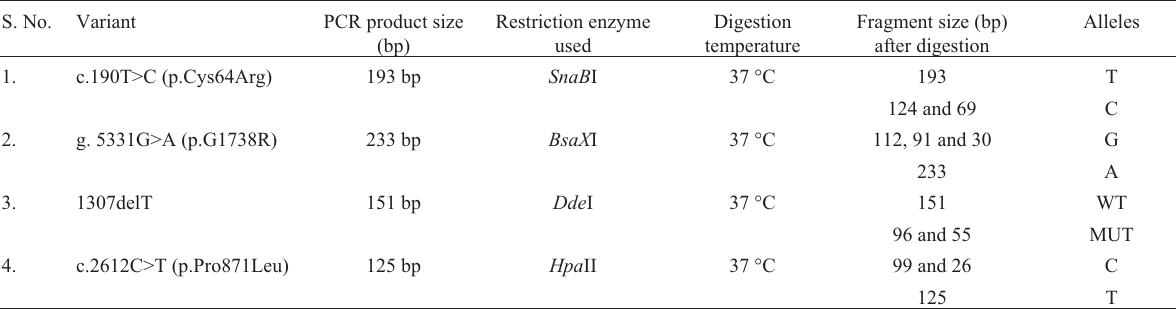
Table 1 - Details of analyzed BRCA1 variants and restriction conditions used for genotyping.